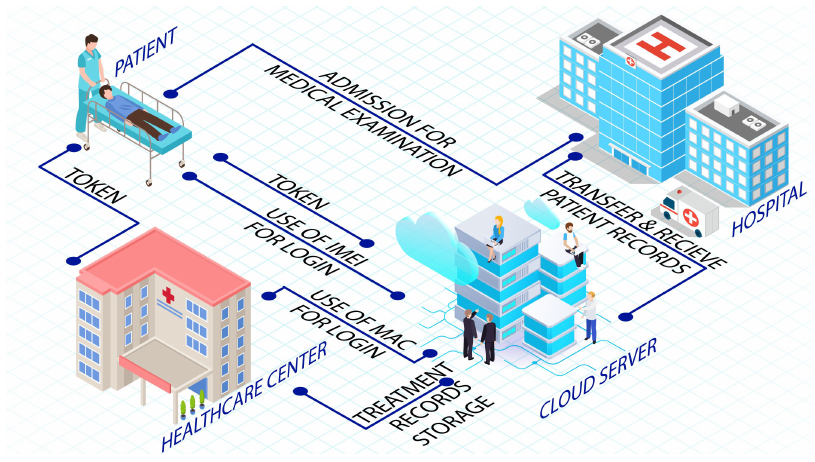
Figure 2. Healthcare authorization model based on cloud authentication